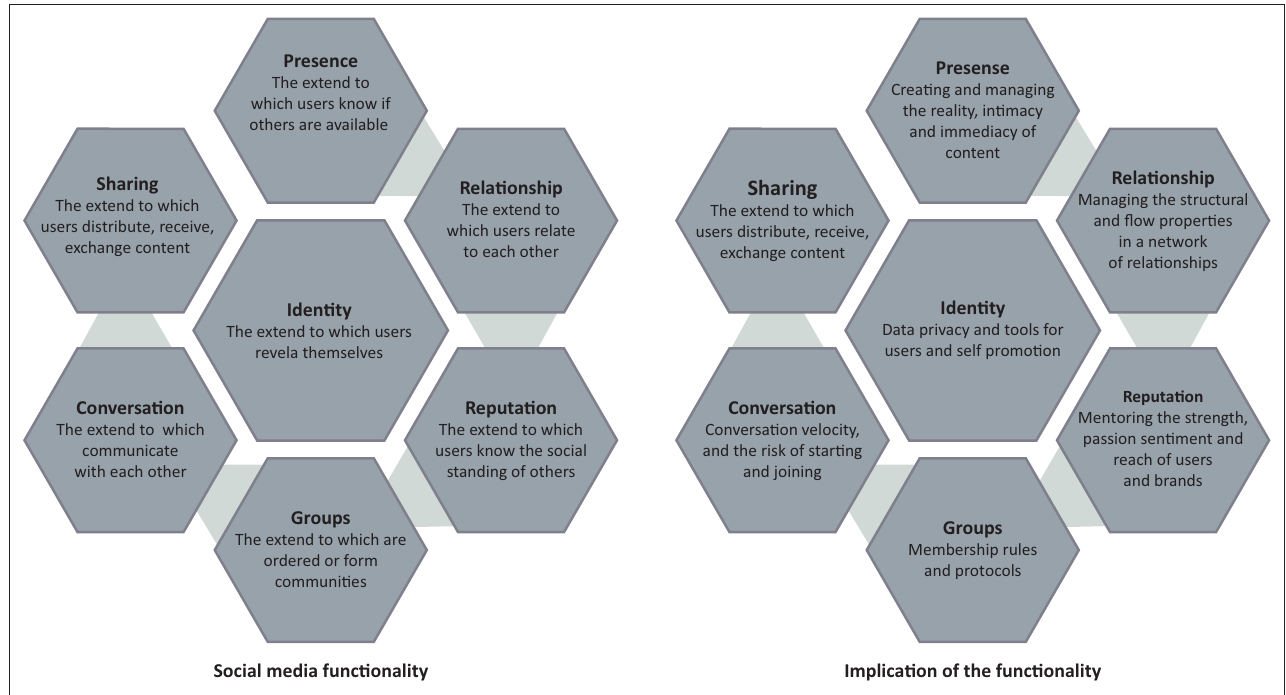
FIGURE 2: The honeycomb of social media